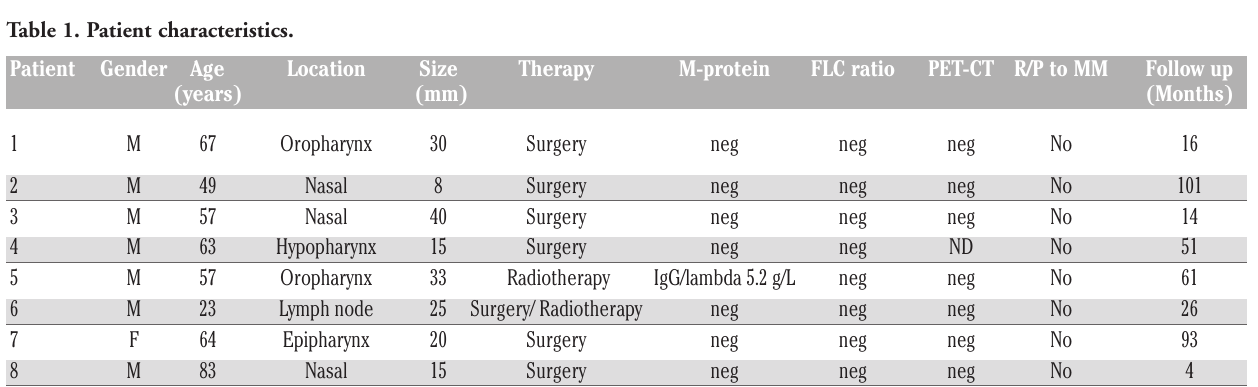
Table 1. Patient characteristics.